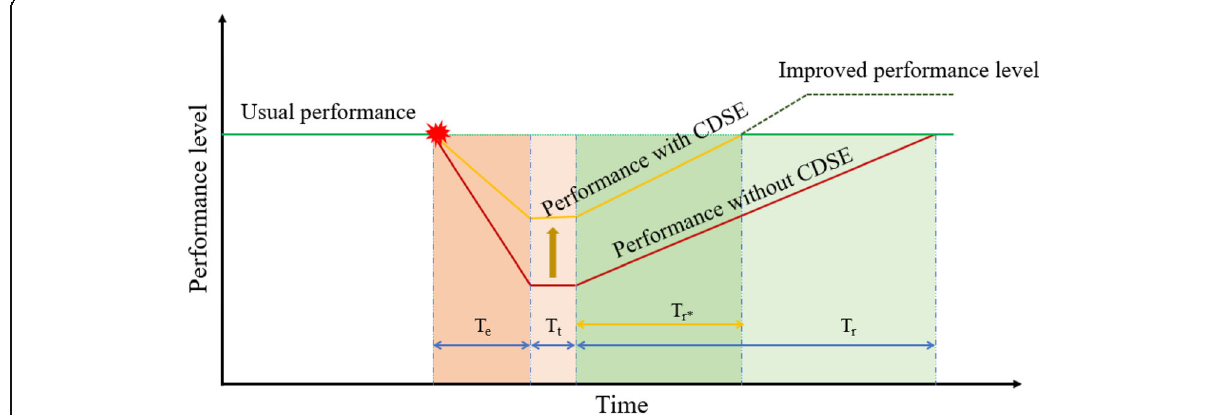
Fig. 2 Conceptual sketch on improvement of community performance due to community disaster science